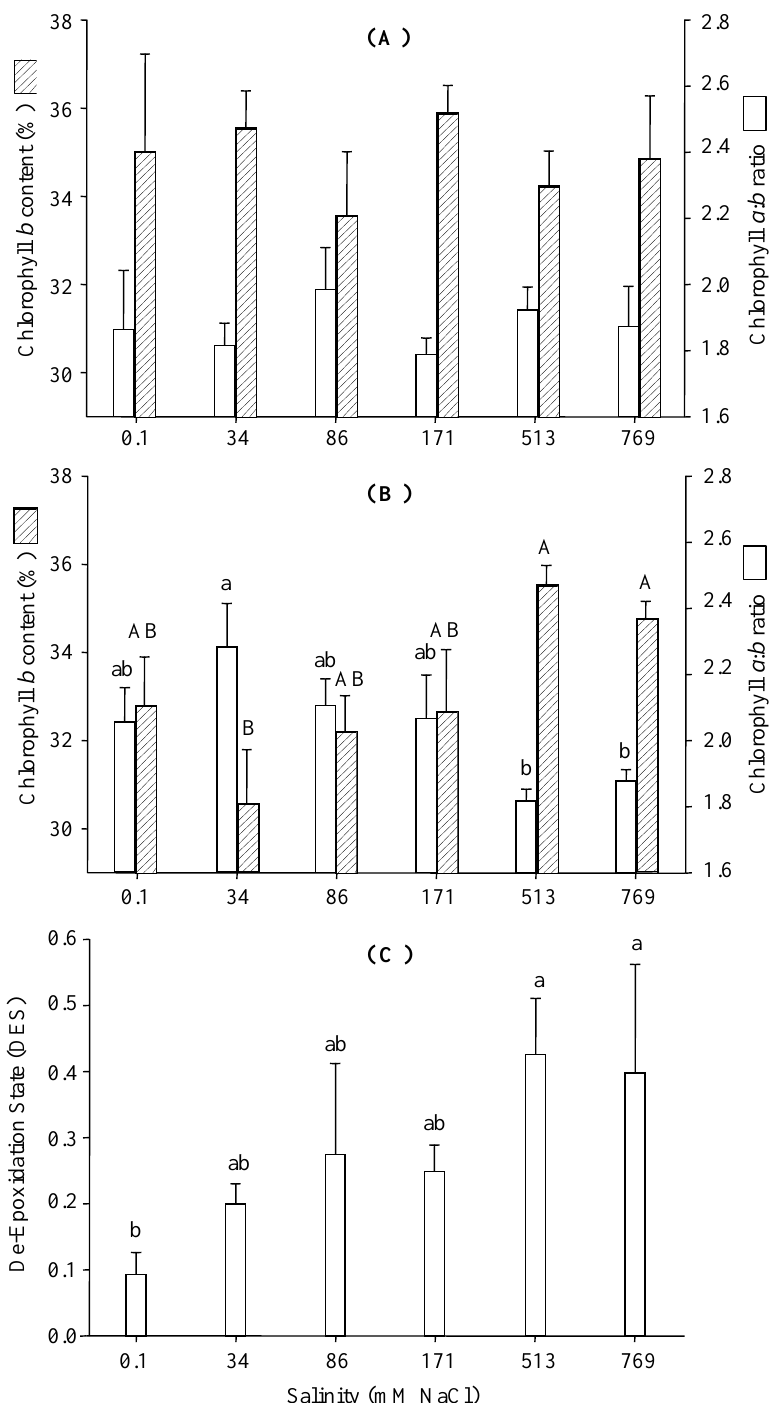
Figure 1. Photo-protective mechanisms of Salicornia neei genotypes under increasing salinities in greenhouse experiment. Chlorophyll a : b ratio and percentage content of chlorophyll b of BTH1 ( A ) and BTH2 genotypes ( B ). De-epoxidation state of xantophylls (DES) of BTH1 genotype ( C ). Different lowercase letters above hollow bars denote significant (Tukey HSD test; p < 0.05) differences of Chlorophyll a : b ratio and DES among salinity levels, while different capital letters above dashed bars denote significant differences of percentage of chlorophyll b among salinity levels.